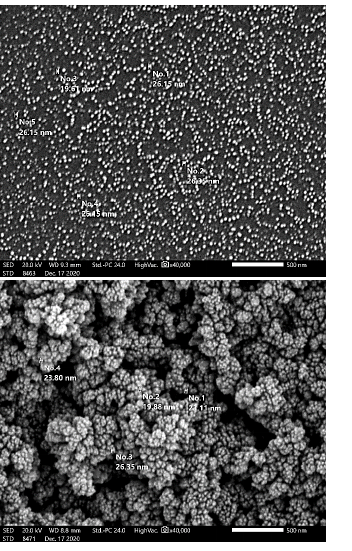
Figure 3: Examples of scanning electron microscopy images of TiO 2 -NPs